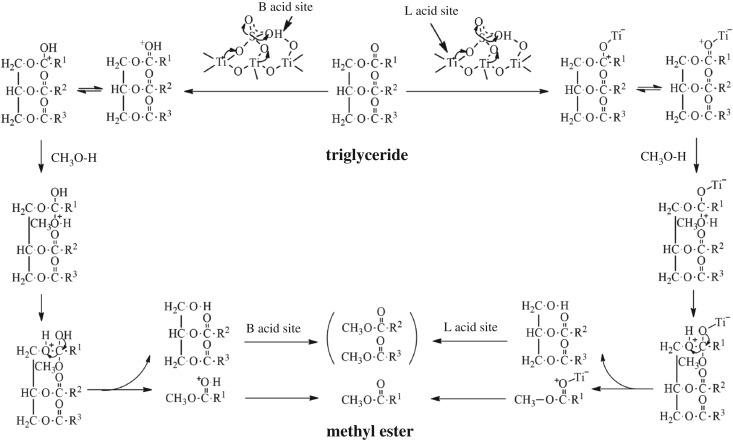
Possible mechanism of transesterification reaction over SO42−/TiO2 catalyst.